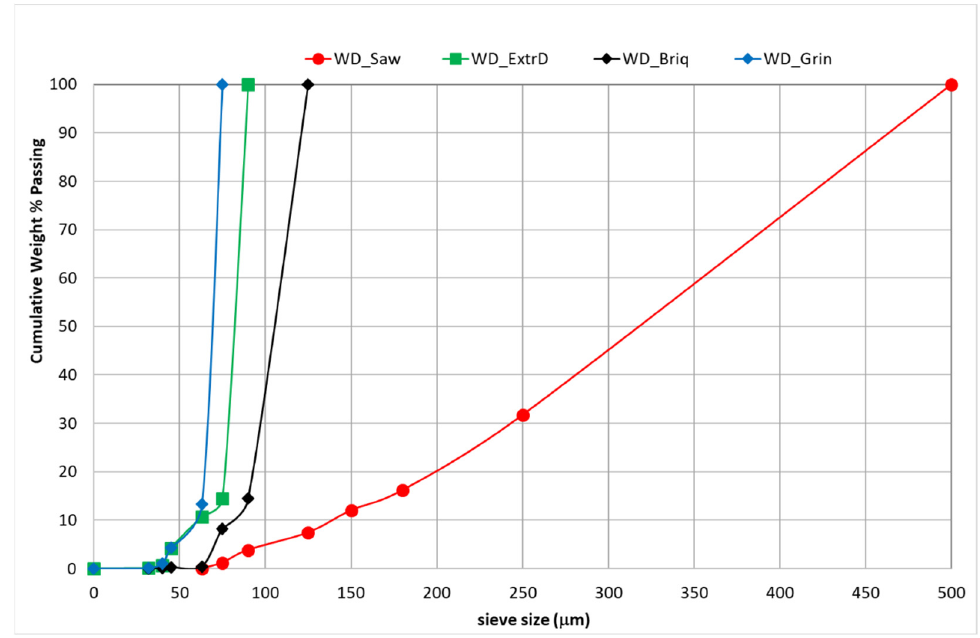
Figure 3. Continuous Cumulative Curve of spruce dust samples. Table 3. Presentation of material parameters of spruce dust samples.